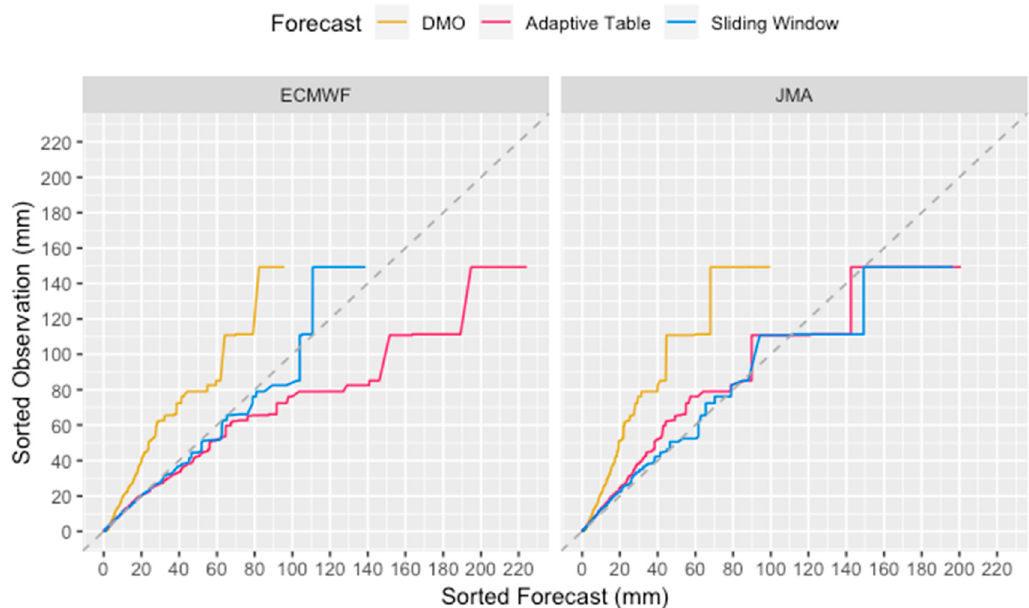
Figure 10. Q-Q plot of the observations against the DMO and the two calibrated forecasts over the verification period. The grey dashed line is y = x , indicating no bias.